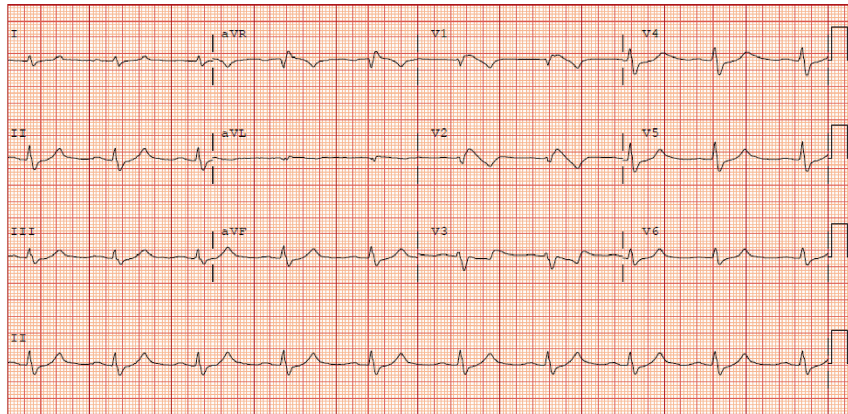
Figure 1: Pre-cardiac arrest ECG.